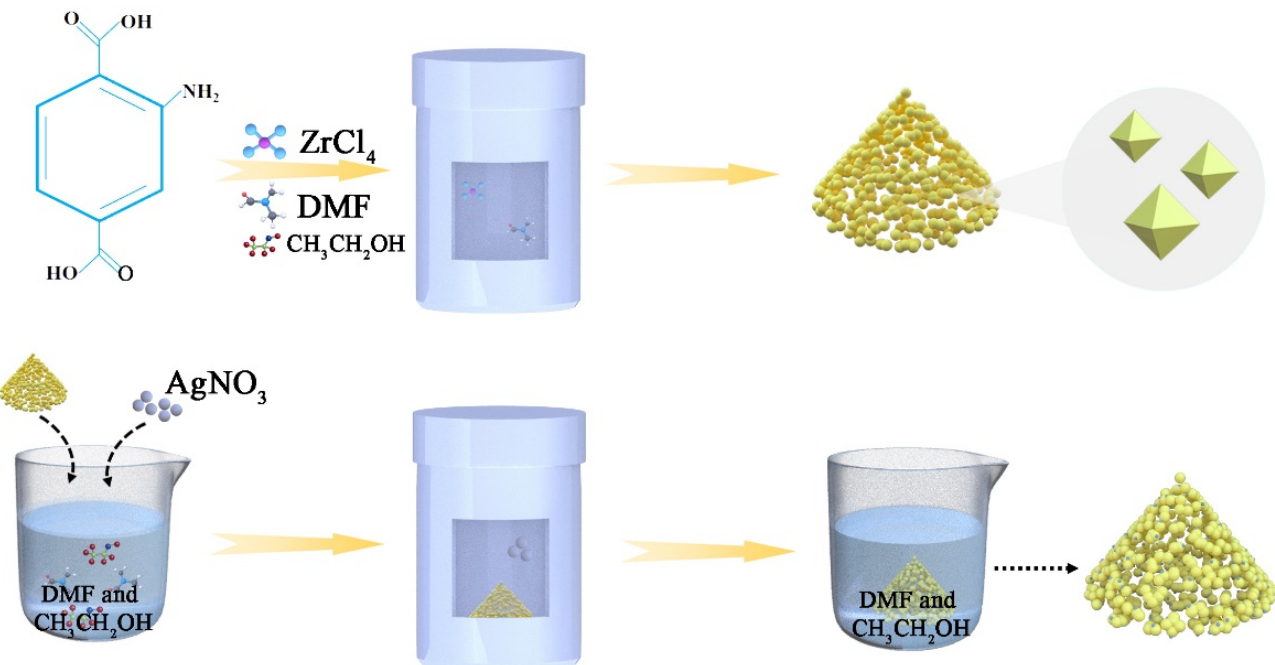
Figure 1. Flow chart presenting the method of material preparation.